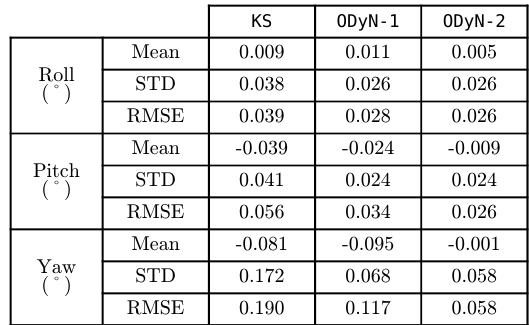
Table 1. Statistics of estimated orientation